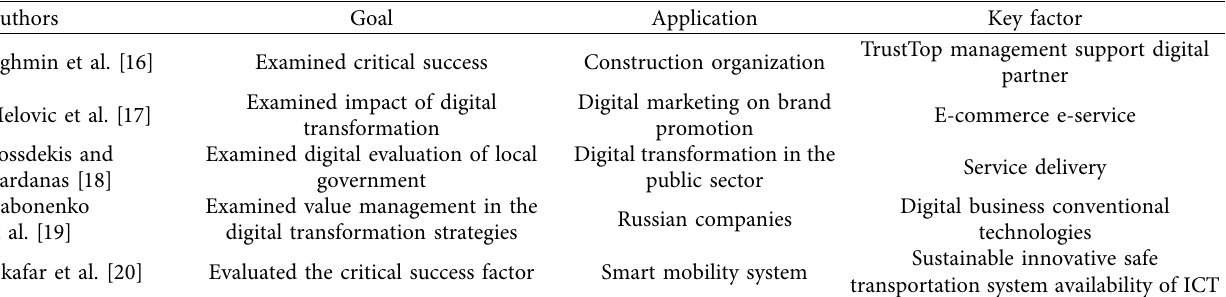
Figure 2: The research conceptual Table 1: Categorized studies.